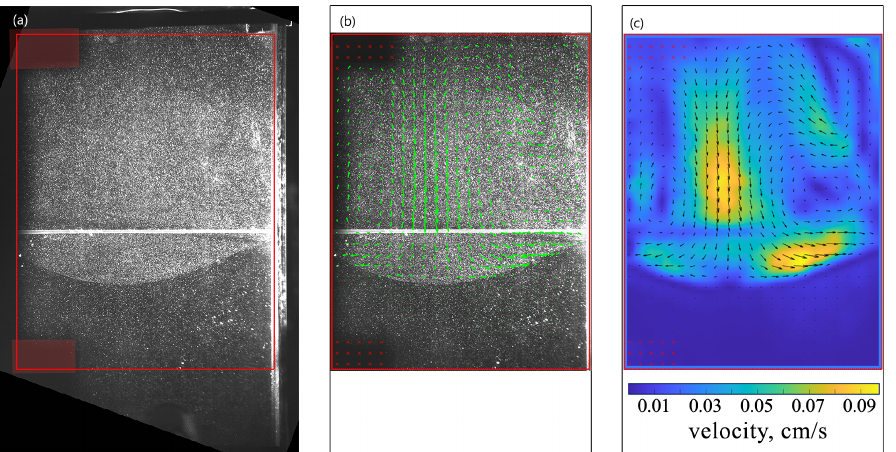
Figure 2. Stages of the velocity field determination for α = 70 ◦ . ( a ) The image demonstrates particle distribution at t = 200 s. The red frame shows the Region of Interest (ROI) for which the velocity field was calculated, and the shaded red areas show the mask applied to regions with shadows cast by the setup parts. ( b ) Superimposed image demonstrating the particle distribution and the corresponding vector field of the time-average fluid velocity calculated by PIV for time t = 200 s. ( c ) The vector plot of the time-average fluid velocity. The density plot presents the scalar field of the average velocity